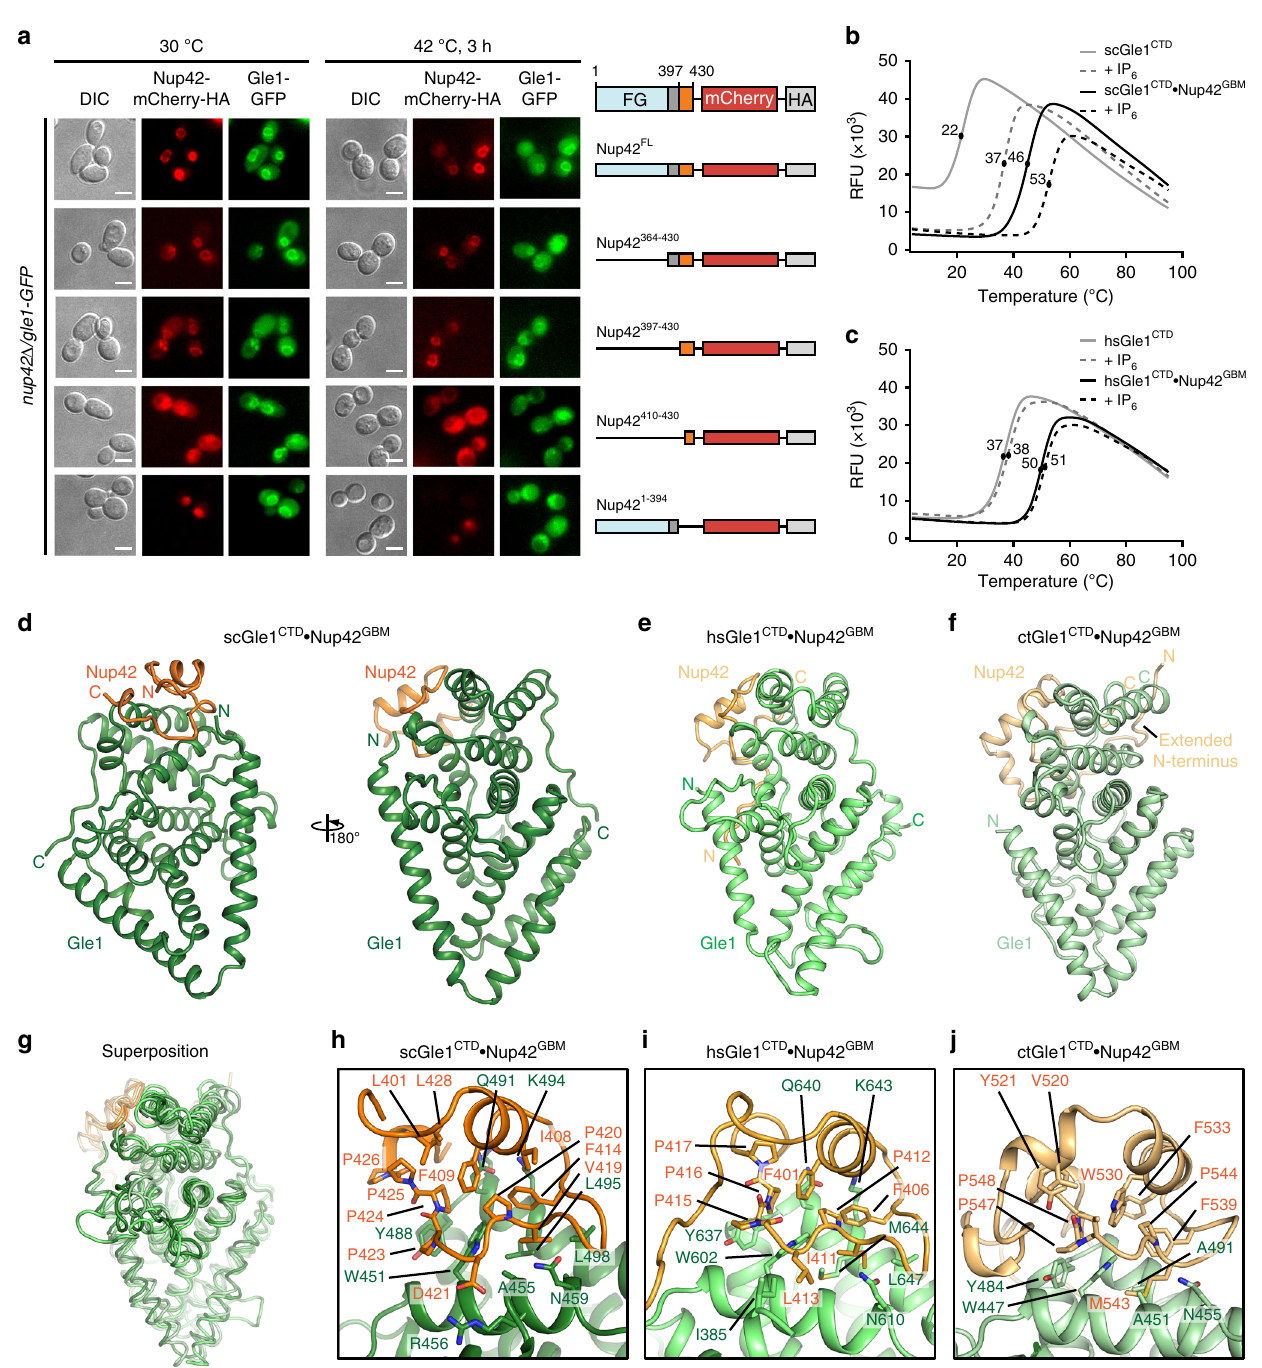
Fig. 2 A conserved mechanism for Gle1 (cid:129) Nup42 complex formation. a In vivo localization analysis of Gle1-GFP and Nup42-mCherry-HA variants in nup42 Δ / gle1-GFP S. cerevisiae cells. Scale bar is 5 μ m. Schematics on the right indicate the Nup42 fragments that were included in the construct, with omitted fragments indicated by replacement of the domain with a solid line. Residue numbers indicate the fragment included in each construct. See also Supplementary Fig. 3. b , c Differential scanning fl uorimetry analysis of b S. cerevisiae or c H. sapiens Gle1 CTD thermostability in the presence and absence of Nup42 GBM and IP 6 . Exposure of hydrophobic residues was monitored by an increase in relative fl uorescence units (RFUs). Curves represent the average of three experiments. See also Supplementary Fig. 4. d − f Crystal structures of d S. cerevisiae , e H. sapiens , or f C. thermophilum Gle1 CTD (cid:129) Nup42 GBM . See also in d − f . See also Supplementary Movie 1. h − j Zoom views of h S. cerevisiae , i H. sapiens , or j C. thermophilum Gle1 CTD (cid:129) Nup42 GBM interactions with